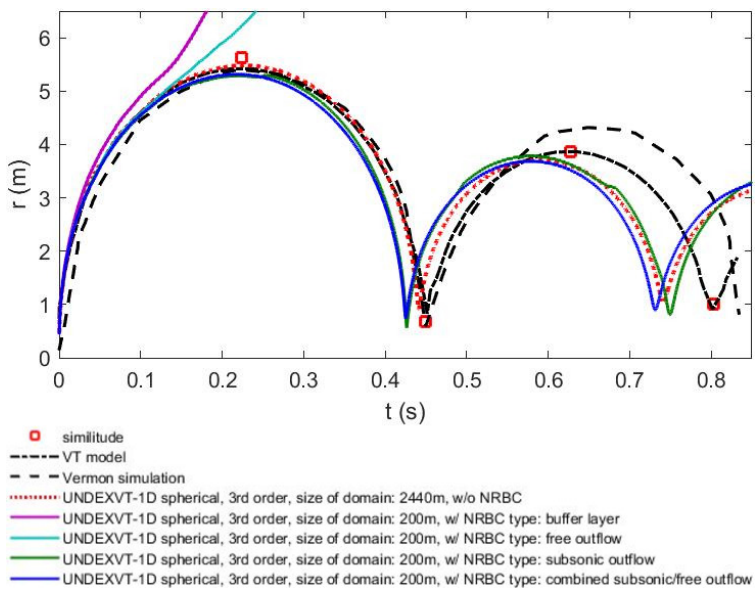
Figure 28. Comparison of the accuracy of the NRBCs.